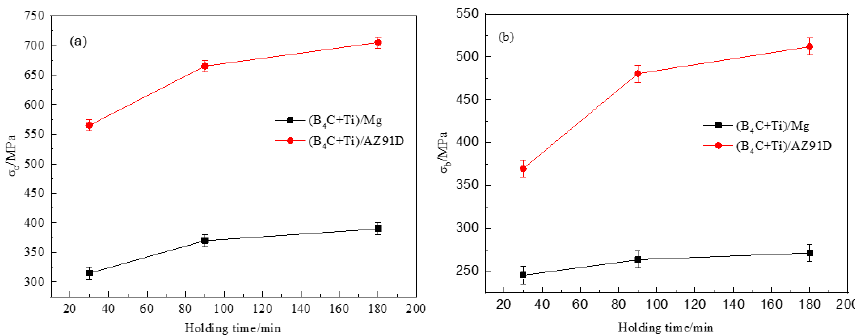
Figure 6. Relationships between compressive strength ( a ) and bending strength; ( b ) of (B 4 C+Ti)/Mg and (B 4 C+Ti)/AZ91D composites and holding time.